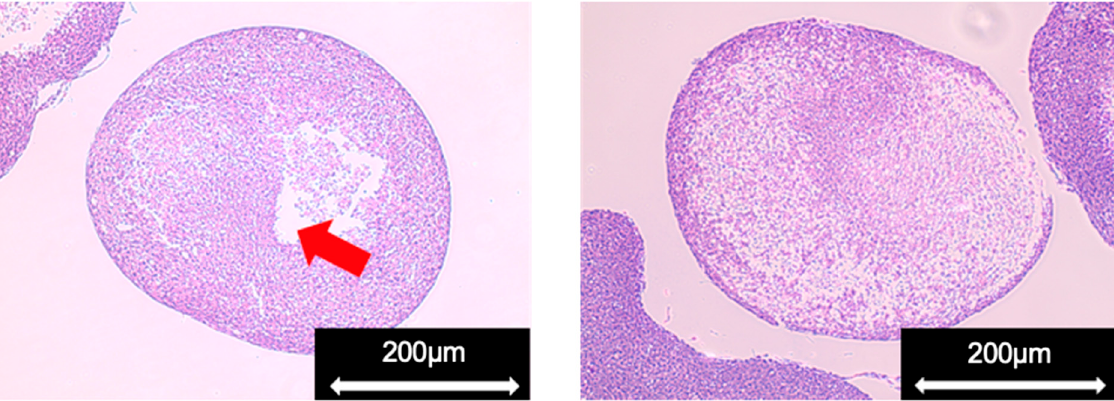
Figure 4. Pathological specimen of a spheroid (ADSC1). Red arrow indicates cavities in the spheroid.